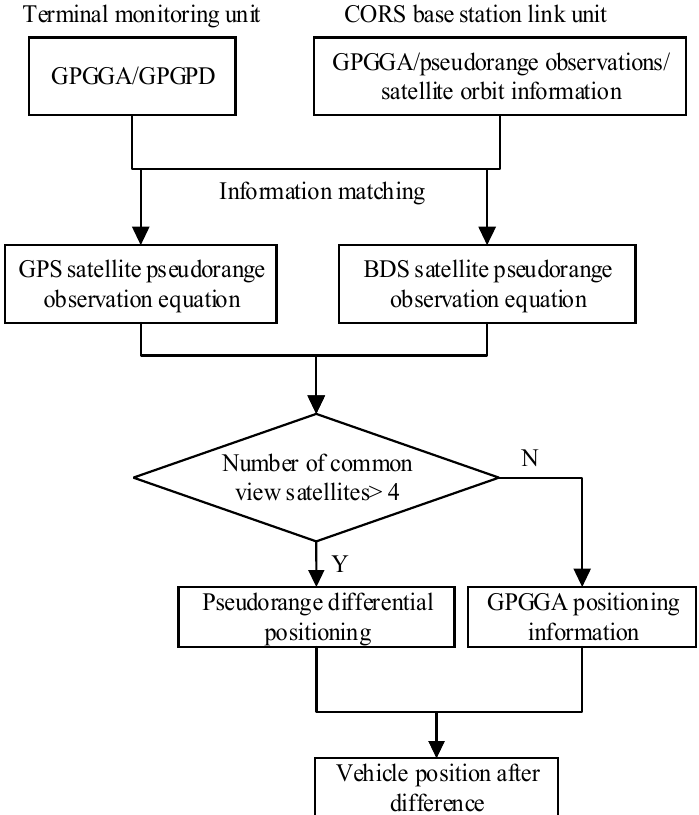
Figure 2. Flow chart of the GPS/BDS pseudorange differential method.